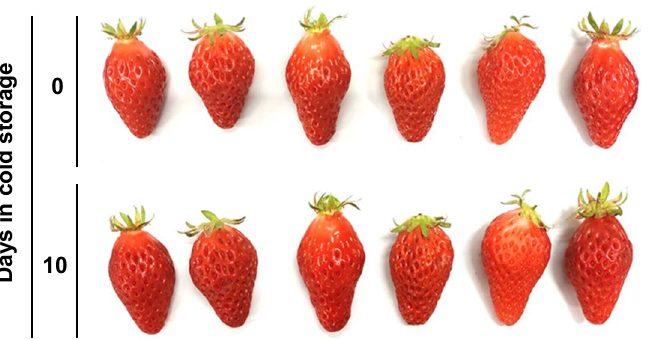
Figure 3. Difference in appearance of strawberry fruits before and after cold storage. Harvested strawberry fruits (upper) were kept at 0 °C for 10 days with porous film bag (lower). Photo represents six biological replications.